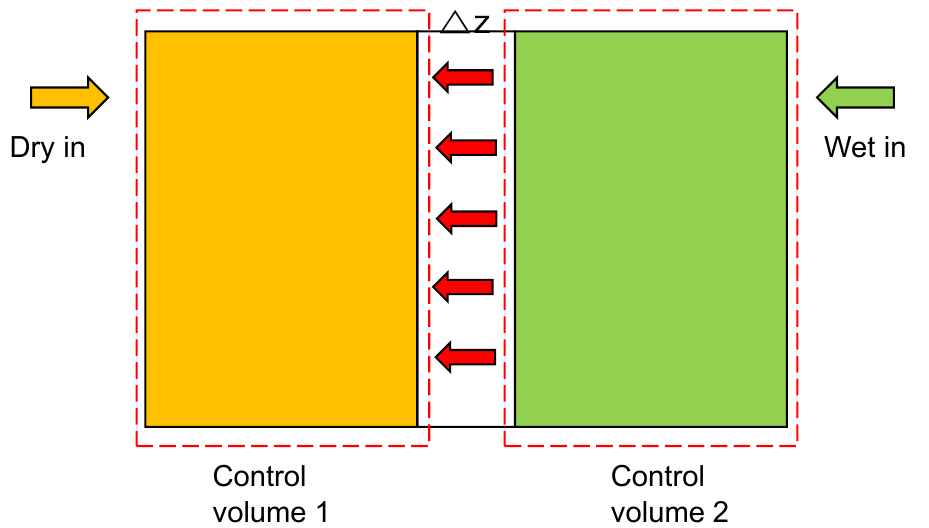
Figure 4. Control volume analysis of water-vapor transport.